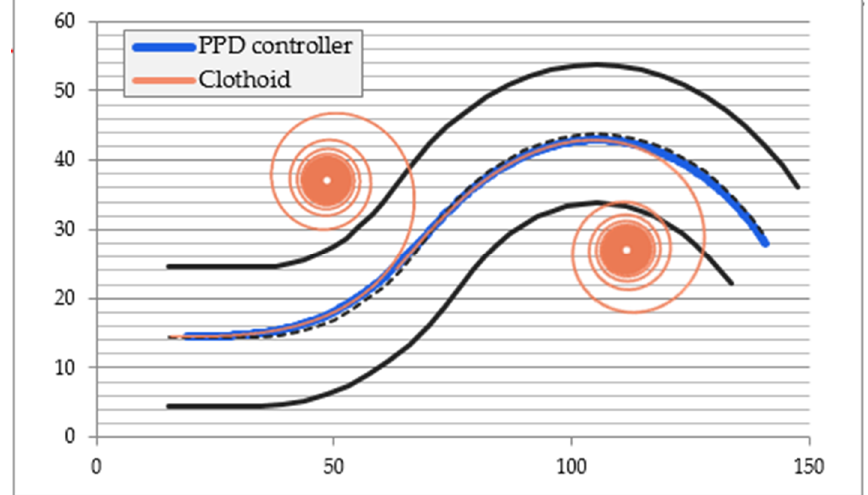
Figure 16. Trajectory of the first left and right turns combined with clothoid spiral. Both turns demonstrate a gradually increasing turning radius.